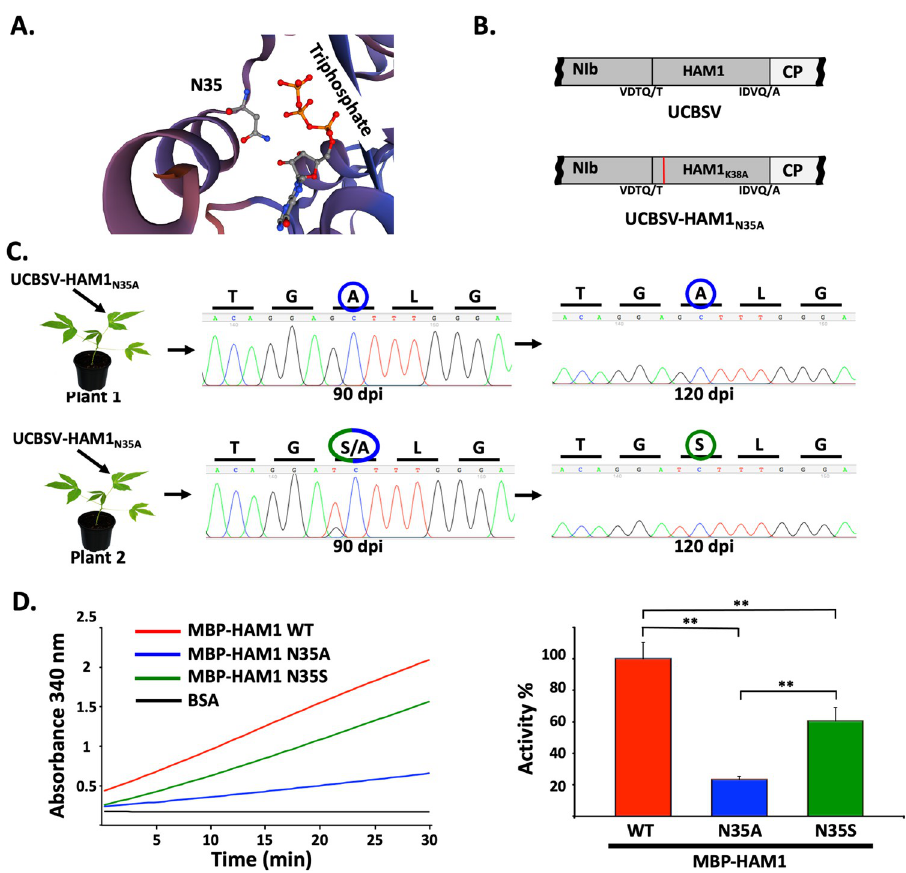
Fig 4. Evolution of a HAM1 partial loss-of-function UCBSV mutant in cassava. (A) Zoom on the model of UCBSV HAM1 tridimensional structureto highlight the locationof the asparagine at position35 inside the catalytic pocket.(B) Schematicrepresentation of the NIb-to-CP genomic segment of viruses used in these experiments. Amino acids around the NIaProcleavage sites are depicted.The presenceof the N35A mutationis indicated with a red line. (C) Chromatograms of Sanger sequencingresults of the DNA fragment of interest amplifiedby RT-PCR. RNA samples deriving from upper non- inoculatedleaves of the indicatedcassava plants inoculated with UCBSV-HAM1N 35A were used as template. Leavesfor RNApreparationwere harvested at both 90 and 120 days post-infection (dpi).Colored circles surroundboth the original and the naturallyintroducedmutation. (D) Left panel:kinetics of ITP hydrolysis,measured by the formation of NADH 2 as indicated in S2A Fig,when10 nanograms of the indicatedproteins were used in the reaction mix. Right panel:bar graph that represents averages of ITPase specific activitywhen different amountof the indicated proteinwere used (n = 3; 10, 20 and 40 nanograms, error bar = 1 standard deviation). For normalization, the average activity of wild-type HAM1 is equalto 100%.Statistical differenceswere testedwith the post-hocTukey HDStest ( �� p < 0.01).